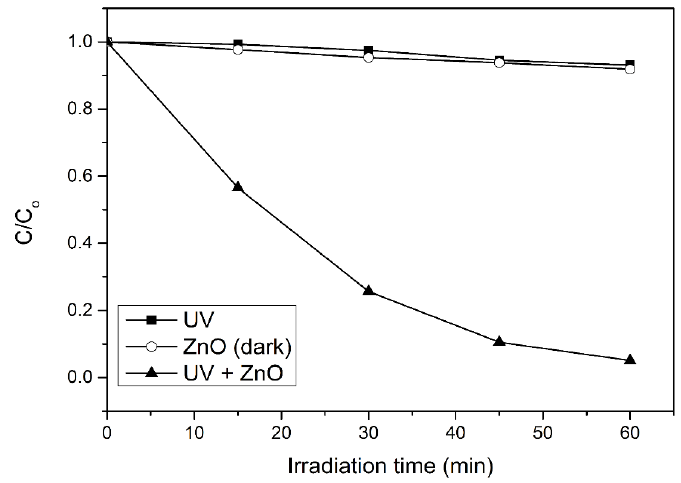
Figure 1. Photocatalytic degradation of 4-CPA under various conditions. Conditions: